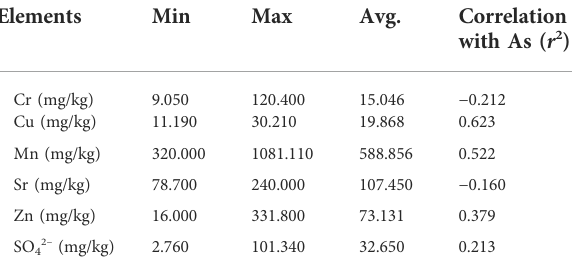
TABLE 2 Statistical data representations of the hydro and geochemical data and correlations with arsenic concentrations in the GW, SW, and